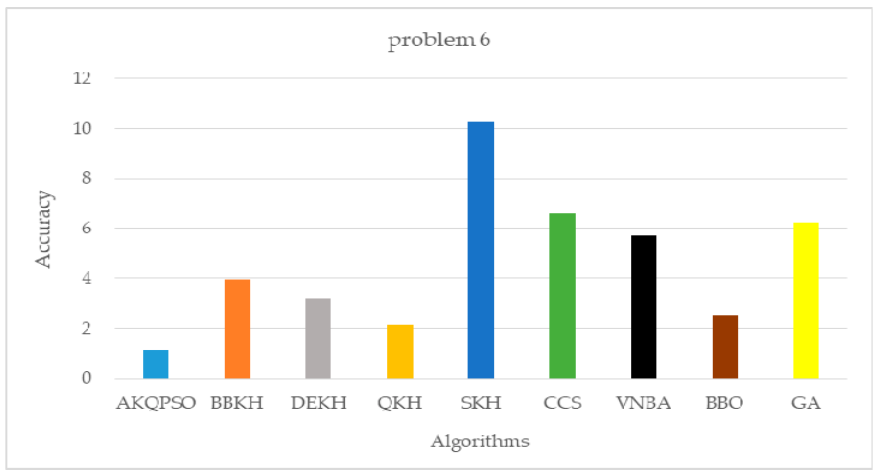
Figure 8. Accuracy of AKQPSO and other algorithms on problem 6: Weierstrass function.